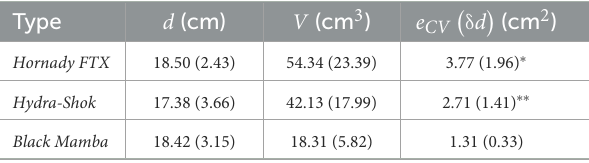
TABLE 1 Results of experiment series A given as mean value (standard deviation) for v and mean value (mean error) for E and ED .